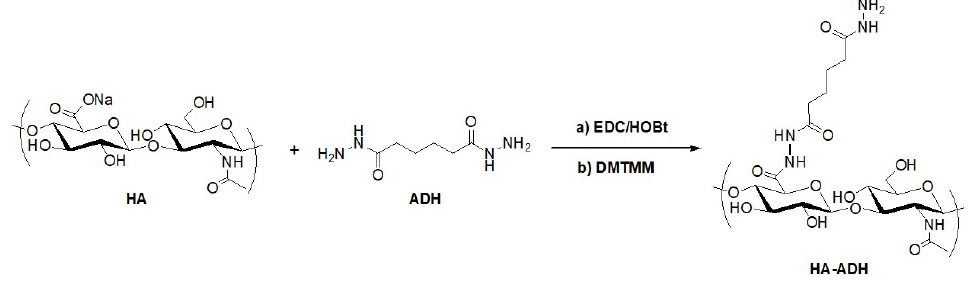
Figure 1. Synthesis of HA modified with ADH using ( a ) EDC/HOBt and ( b ) DMTMM. The second type of polysaccharide modification consisted of HA (Figure 2) and dextran oxidation. For this purpose, reactions mediated by NaIO 4 were carried out [67,68], leading to polysaccharide polyaldehydes. Oxidized HA (HA-OX) and oxidized dextran (DEX-OX) were prepared with different degrees of oxidation (DO)—35 and 62 for HA-OX, and 49 for DEX-OX. The molecular weight of the polymers decreased to 7.5 kDa–9.0 kDa due to oxidation. The presence of formed carbonyl groups in biopolymer chains further enabled utilisation of HA-OX and DEX-OX for hydrogel formation after reaction with HA-ADH.